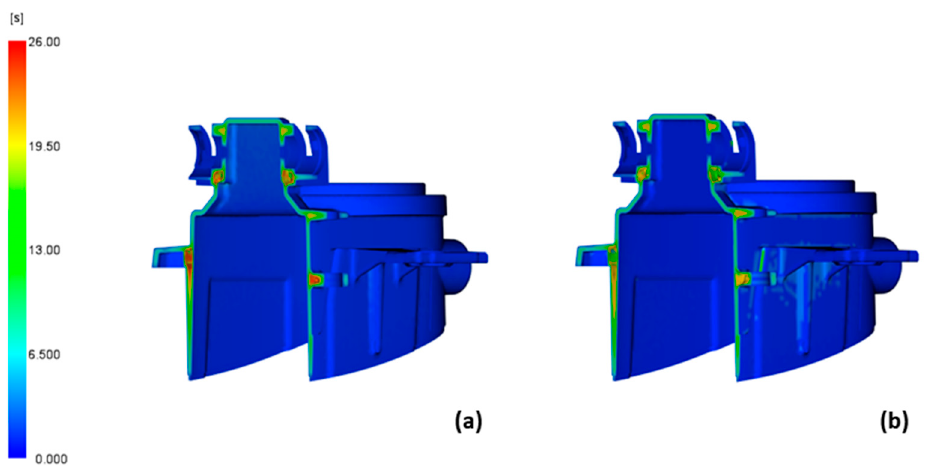
Figure 5. Time to reach the ejection temperature in the cross section at the critical area of the product calculated with conventional cooling ( a ) and with conformal cooling ( b ).